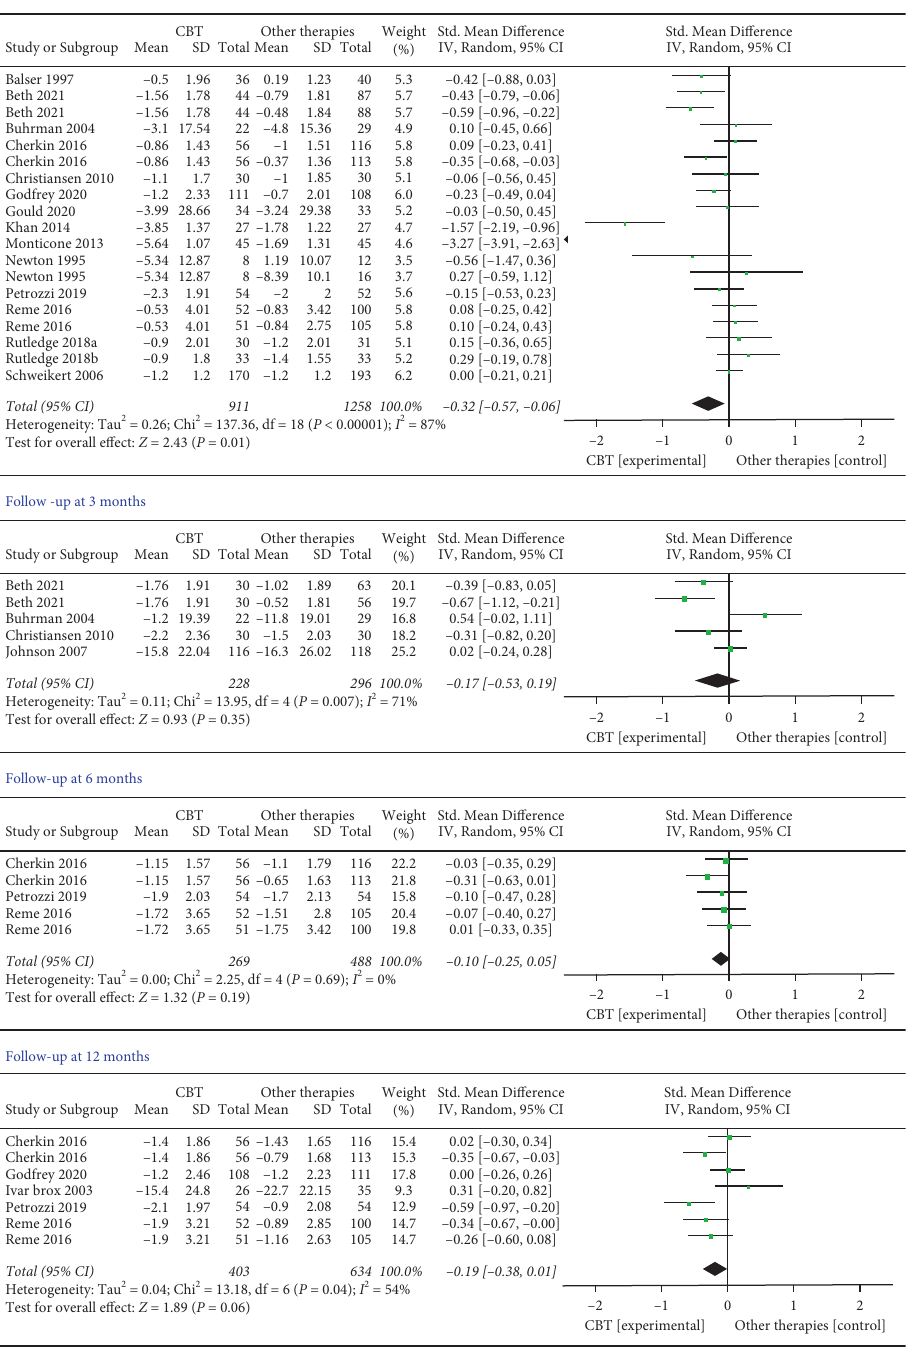
Figure 3: Pain intensity immediately after intervention and during the follow-up period. Compared with other therapies, the overall effect of CBT on pain outcome immediately after intervention was significant ( P < 0 . 05). All the follow-up periods failed to show statistical